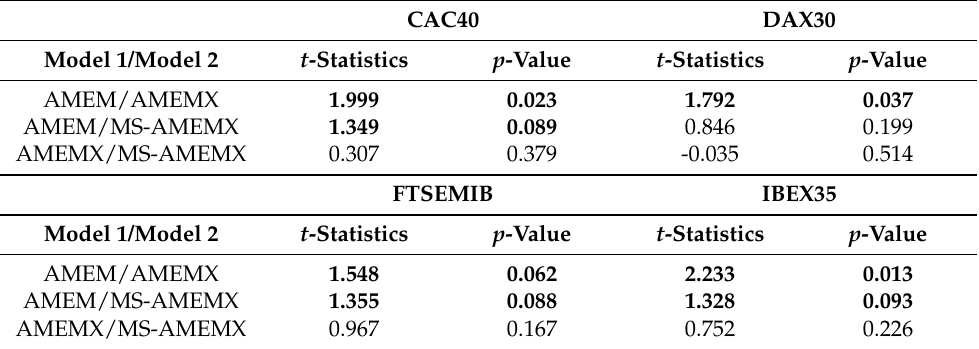
Table 7. t -statistics and p -value of the Diebold–Mariano test. H 0 : MSE (model 1) = MSE